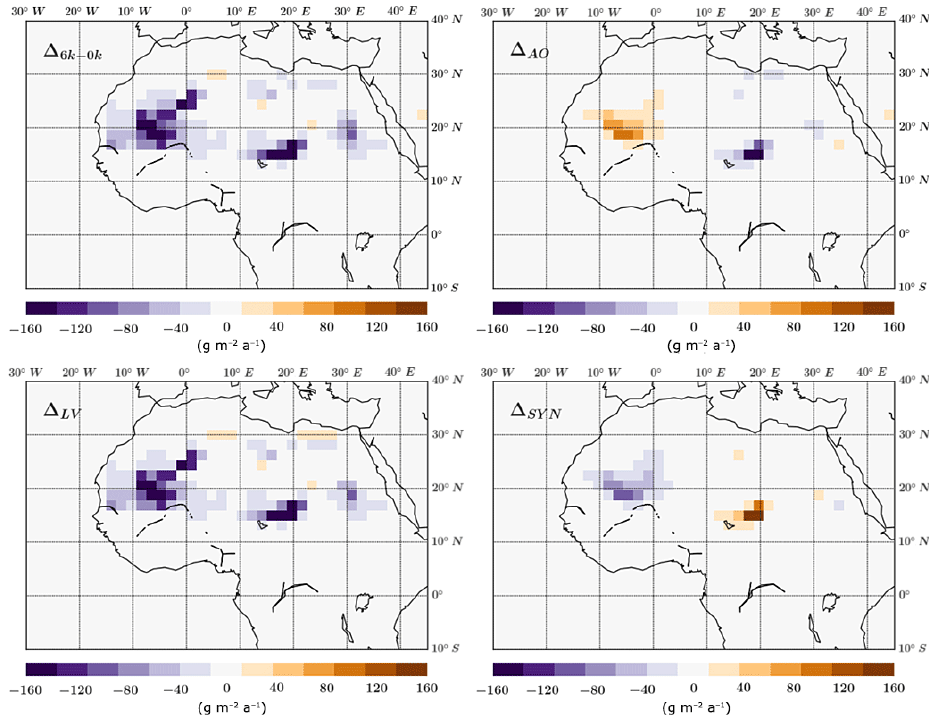
Figure 7. Differences in simulated dust emission in North Africa (17 ◦ W–40 ◦ E; 10–30 ◦ N) between 6 k and 0 k , (cid:49) 6 k − 0 k (top left), (cid:49) AO (top right), (cid:49) LV (bottom left) and the synergy effect (cid:49) SYN (bottom